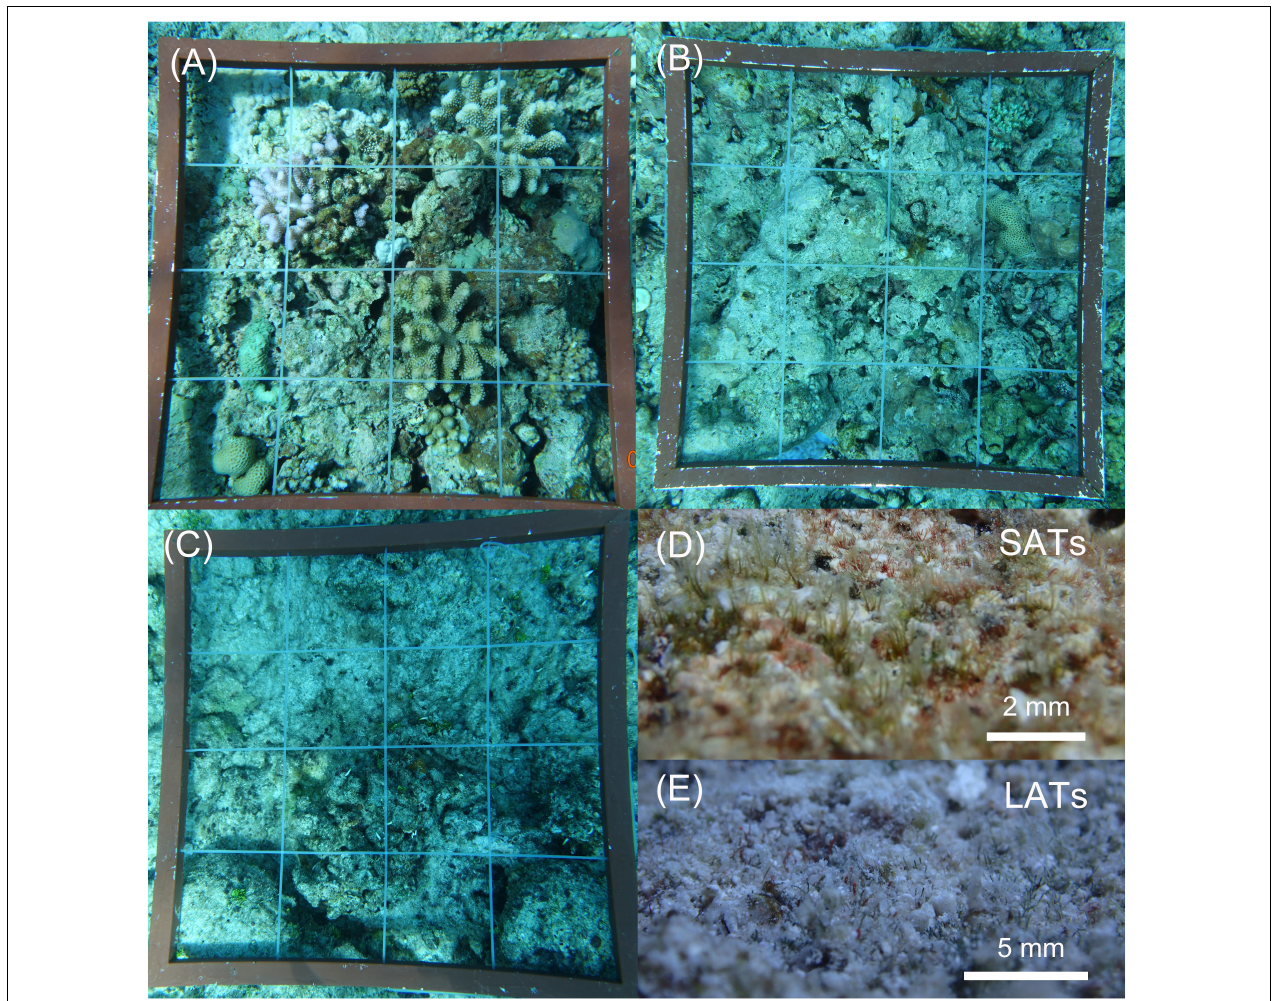
FIGURE 2 | Benthic coral reef conditions of the different study reefs. The 0.25 m 2 quadrats were divided into a 4 × 4 grid using strings at 12.5 cm intervals along the vertical and horizontal axes. (A) Coral-dominated reefs with a complex benthic structure and high coral coverage; (B) Reefs with low macroalgae cover had a large area and flat, hard substratum. (C) Reefs with the lowest coral cover and highest coverage of dense algal turfs and macroalgae; (D) The “dead hard substratum” was primarily covered by short (length was approximately 2 mm) and sparse algal turfs (SATs). (E) Long (length was more than 5 mm) and dense algal turfs (LATs) laden with large amounts of sediments dominated in low coral cover